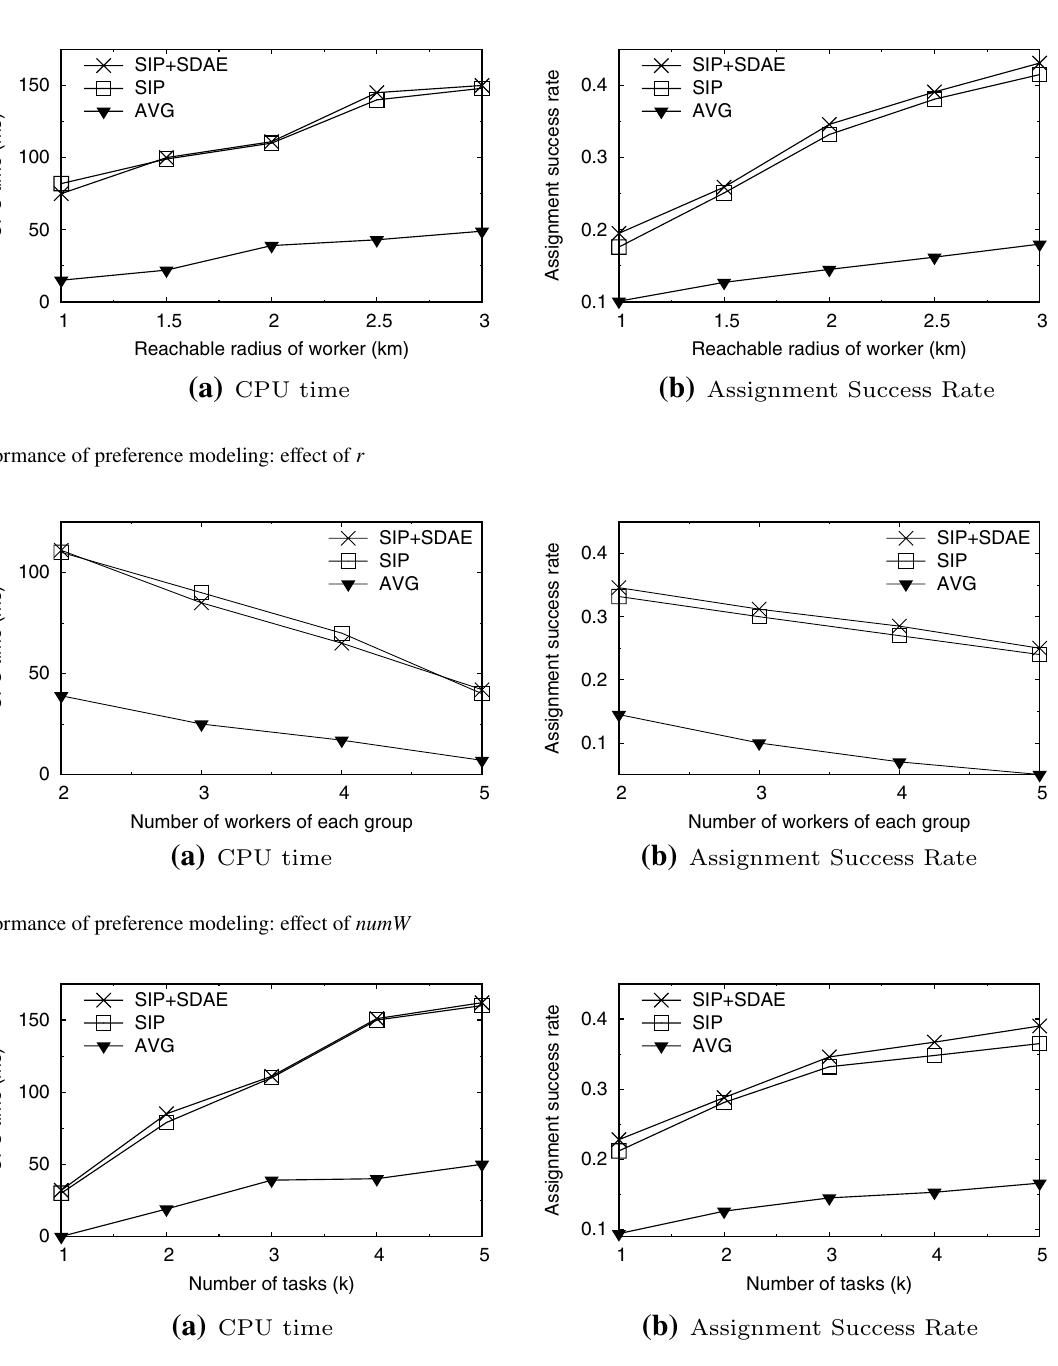
Fig. 7 Performance of preference modeling: effect of | S